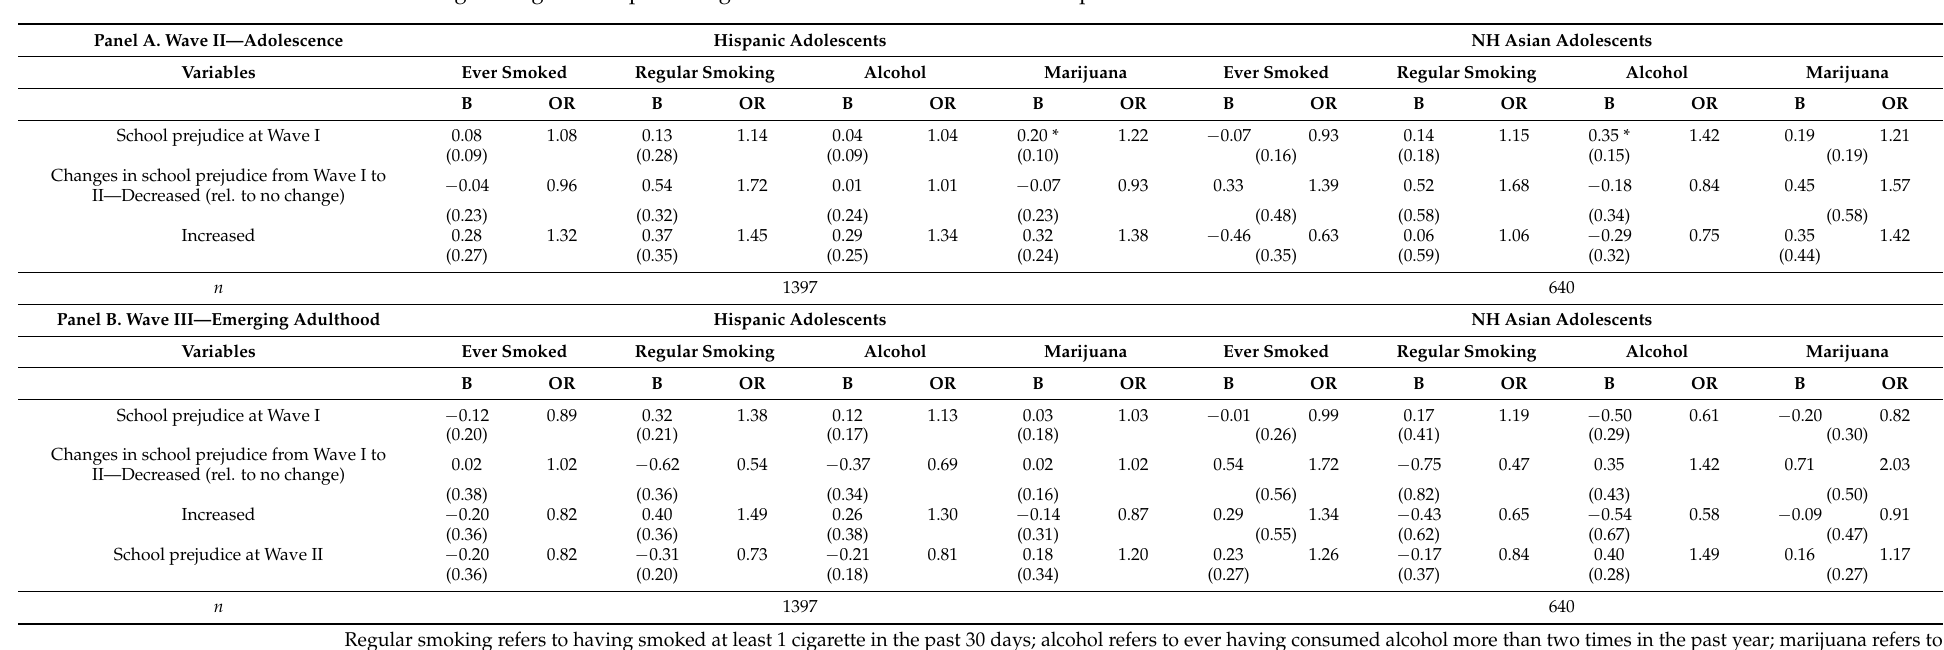
Table 5. Logistic regressions predicting likelihood of substance use for Hispanic and Asian adolescents at Waves II and